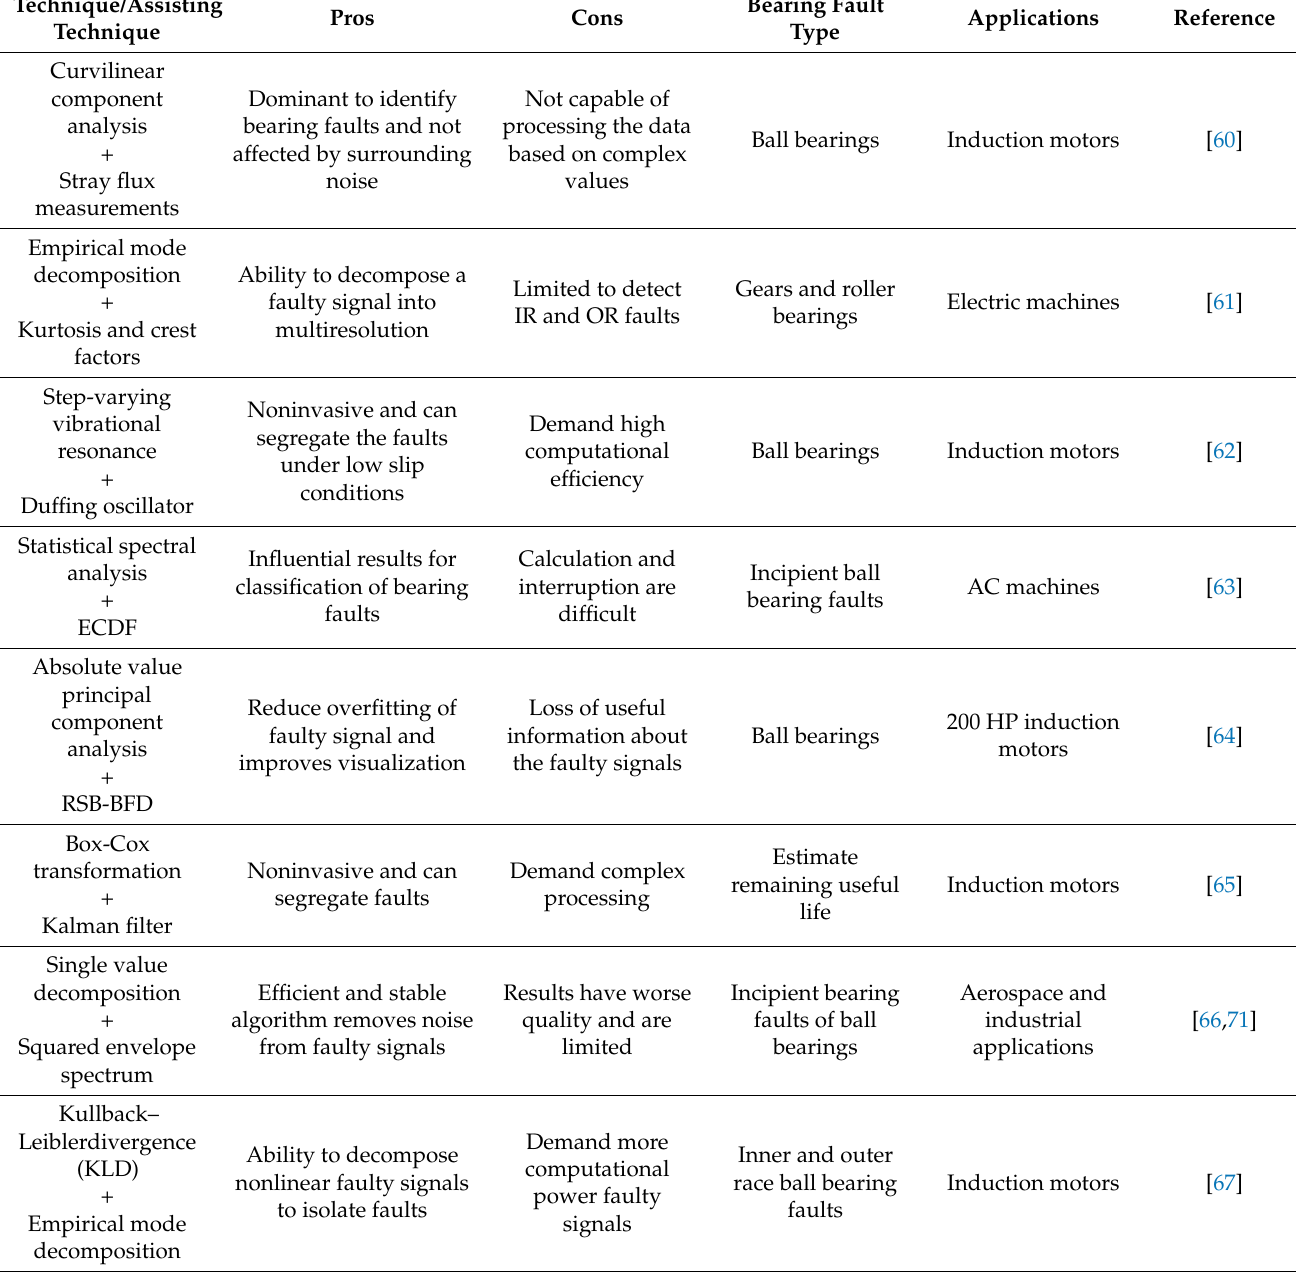
Table 2. A summary of different statistical techniques for bearing fault